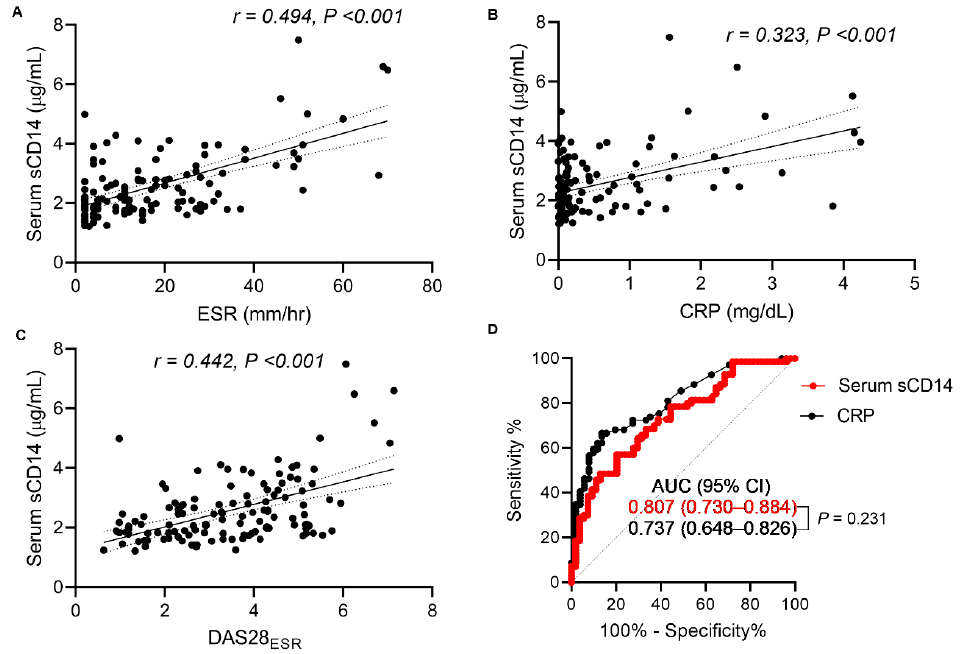
Figure 2. Correlation between serum sCD14 levels (measured by FREND ™ ) with RA disease activity. ( A – C ) Spearman’s correlation analysis of the relationship between serum sCD14 levels (measured by the FREND ™ -CD14 system) and ESR, CRP, and the DAS28ESR. ( D ) Area under a receiver